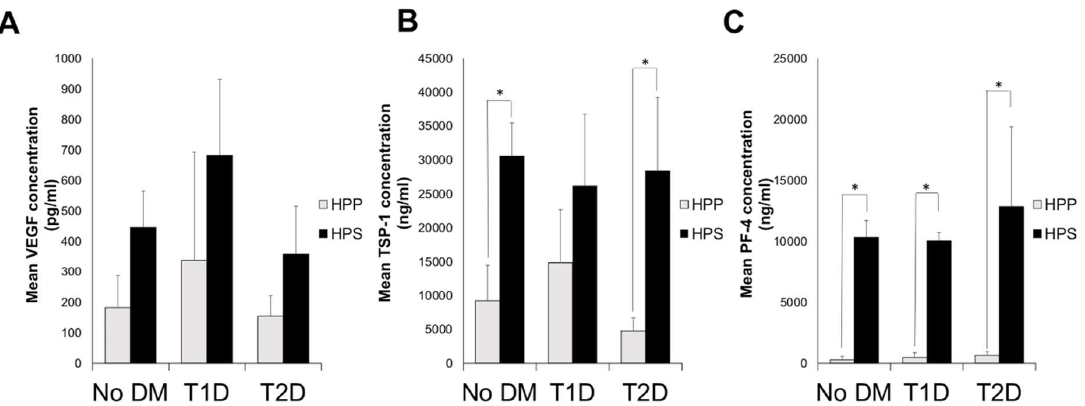
Figure 4. Comparative analysis of pro- (VEGF) and antiangiogenic (TSP-1 and PF-4) factor concentrations in hypoxia preconditioned blood-derived secretomes obtained from diabetic and nondiabetic subjects. Plot showing the concentrations of ( A ) VEGF (pg/mL), ( B ) TSP-1 (ng/mL), and ( C ) PF-4 (ng/mL) in HPP and HPS samples obtained from subjects suffering from type 1 (T1D) or type 2 (T2D) diabetes mellitus (DM) and nondiabetic subjects (no DM). For all pair comparisons, * p < 0.05, unless otherwise indicated. Error bars represent s.d.; number of subjects tested: no DM, n = 8; T1D, n = 6; and T2D, n = 10. At least one assay well was tested per subject per condition.